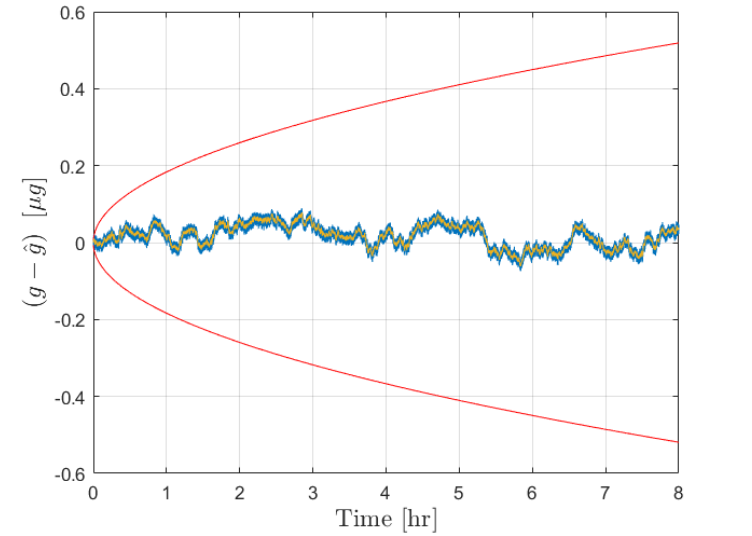
Figure 3. Results for the forcing acceleration estimate error from the moving least squares procedure. Estimate error is plotted in blue with the associated 3 σ bounds in red. This is accompanied by the true bias time history in yellow.